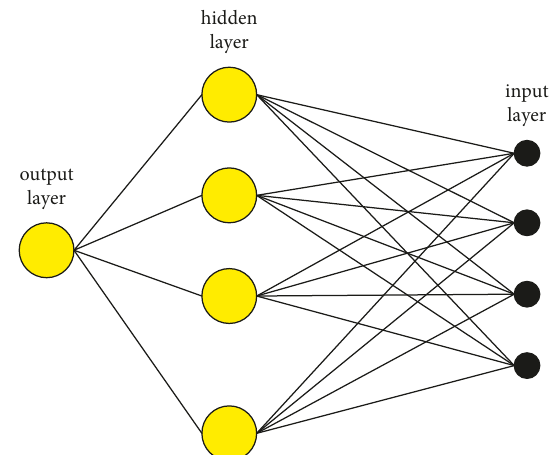
Figure 3: Network structure of RBF neural